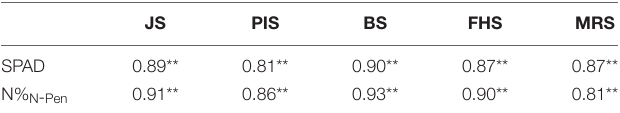
TABLE 4 | Pearson’s correlation coefficients for the correlation analysis between Nitrogen content measured by EQA (N% EQA ) and Soil Plant Analysis Development (SPAD), and between N% EQA and N-pen meter (N% N - Pen ).